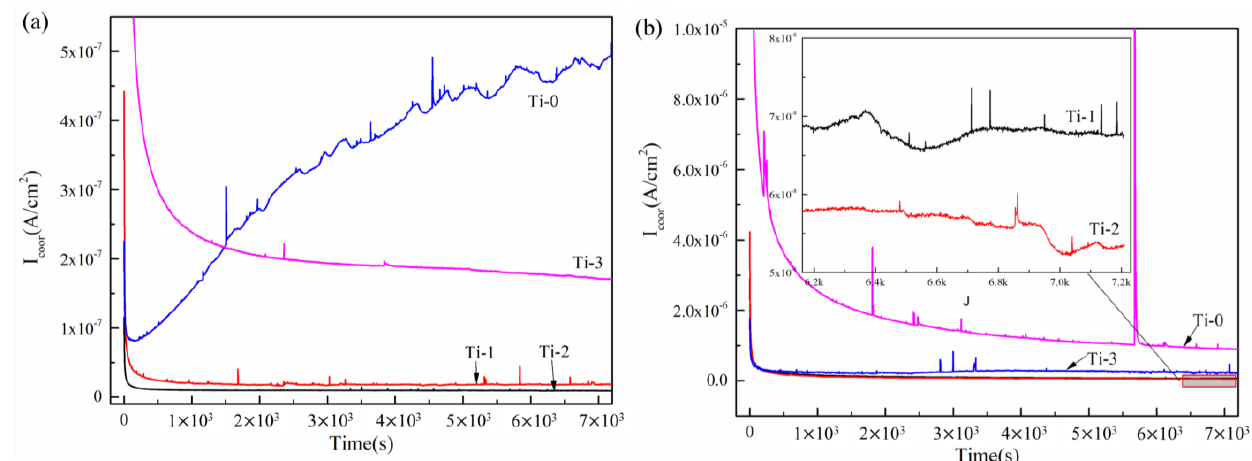
Figure 7. Potentiostatic polarization curves of Cr, Ti co-doped amorphous carbon film: ( a ) +0.6 V (vs. SCE), ( b ) +1.1 V (vs. SHE).